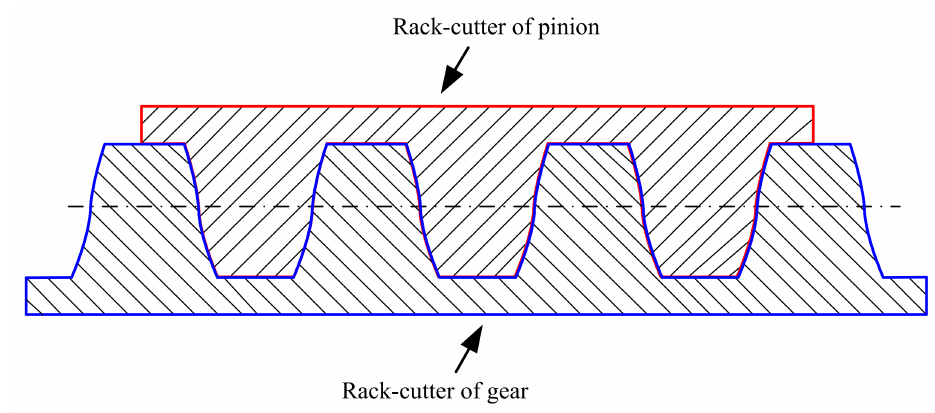
Figure 12. The tooth profile of the rack-cutters of the novel pinion and gear, k 1 = k 2 =